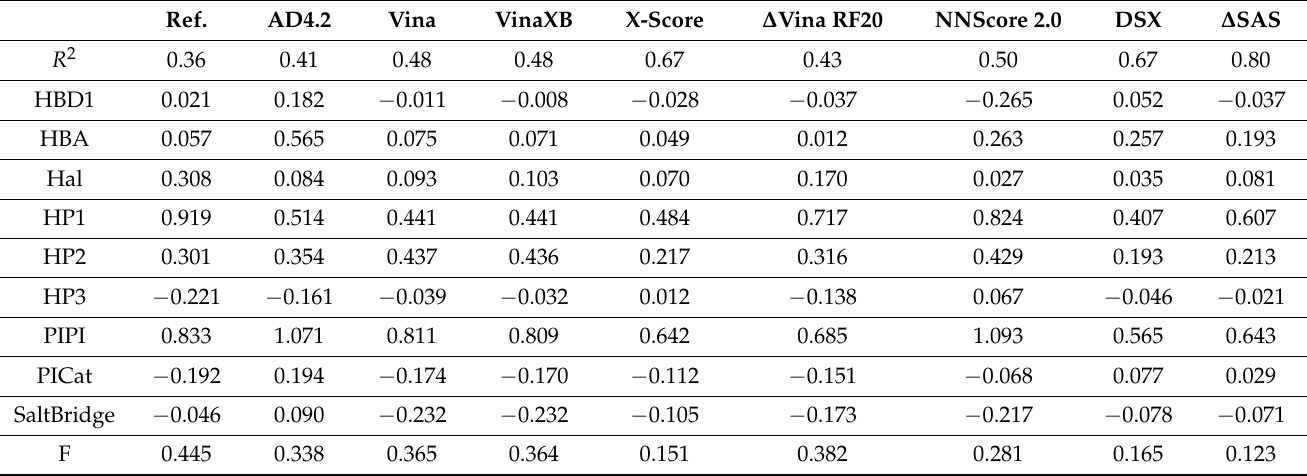
Table 5. Statistical performance ( R 2 ) and the values of the coefficients of the Lasso model, relating the activity, predicted by scoring functions, and the presence of chemical features responsible for basic interactions. Regularization parameter, λ , is set to 1 × 10 − 4 .